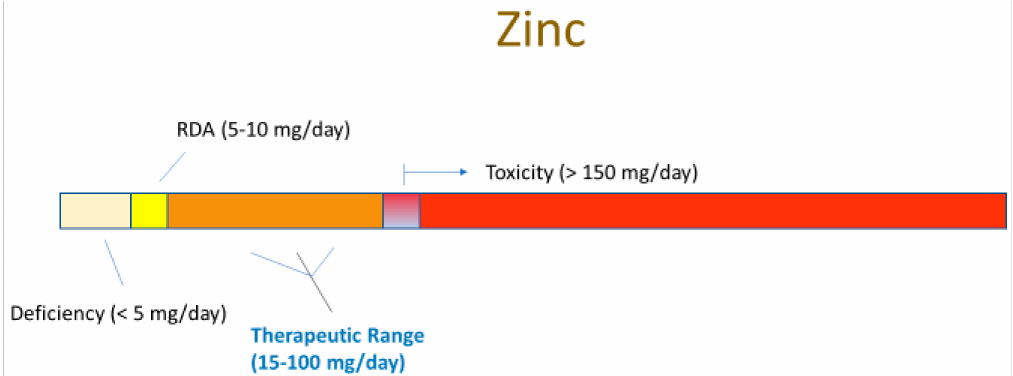
Figure 3. Various cell culture, animal and human studies indicate that intake of 20–100 mg of zinc per adult per day (which will result in transient blood levels in the 25–100 µ M range) can achieve beneficial, zinc-induced physiological changes, among which may be TJ remodeling and barrier